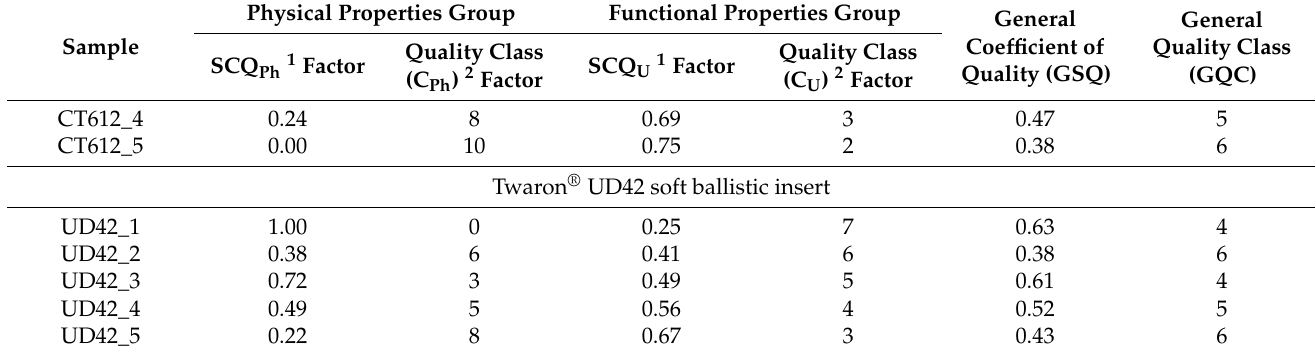
Table 6. Selection of the optimal variants of para-aramid soft ballistic inserts.